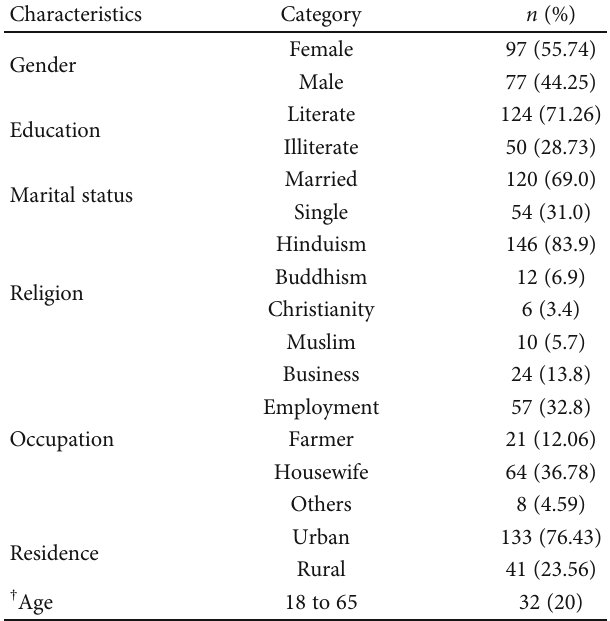
Table 1: Sociodemographic characteristics of patients ( n = 174